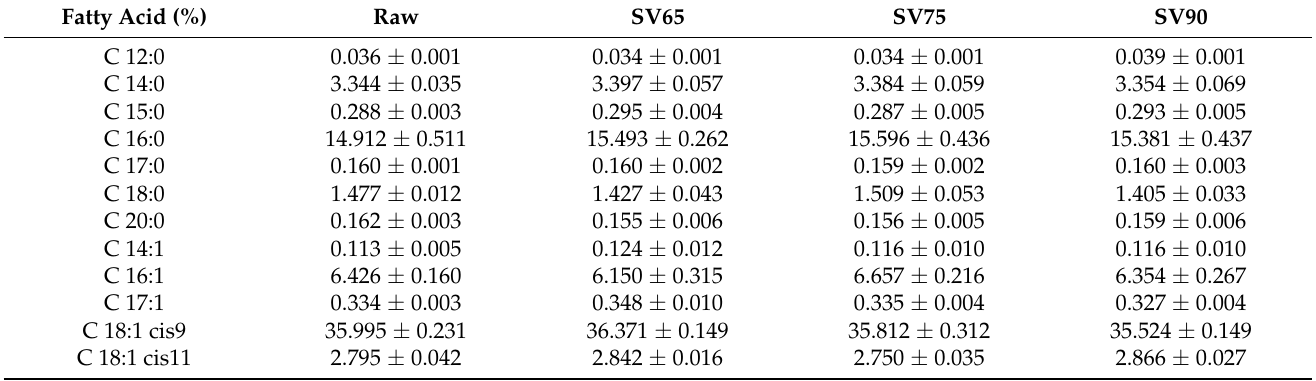
Table 3. Fatty acid composition (% of total) of raw and sous vide cooked pikeperch (mean values and standard error of mean in